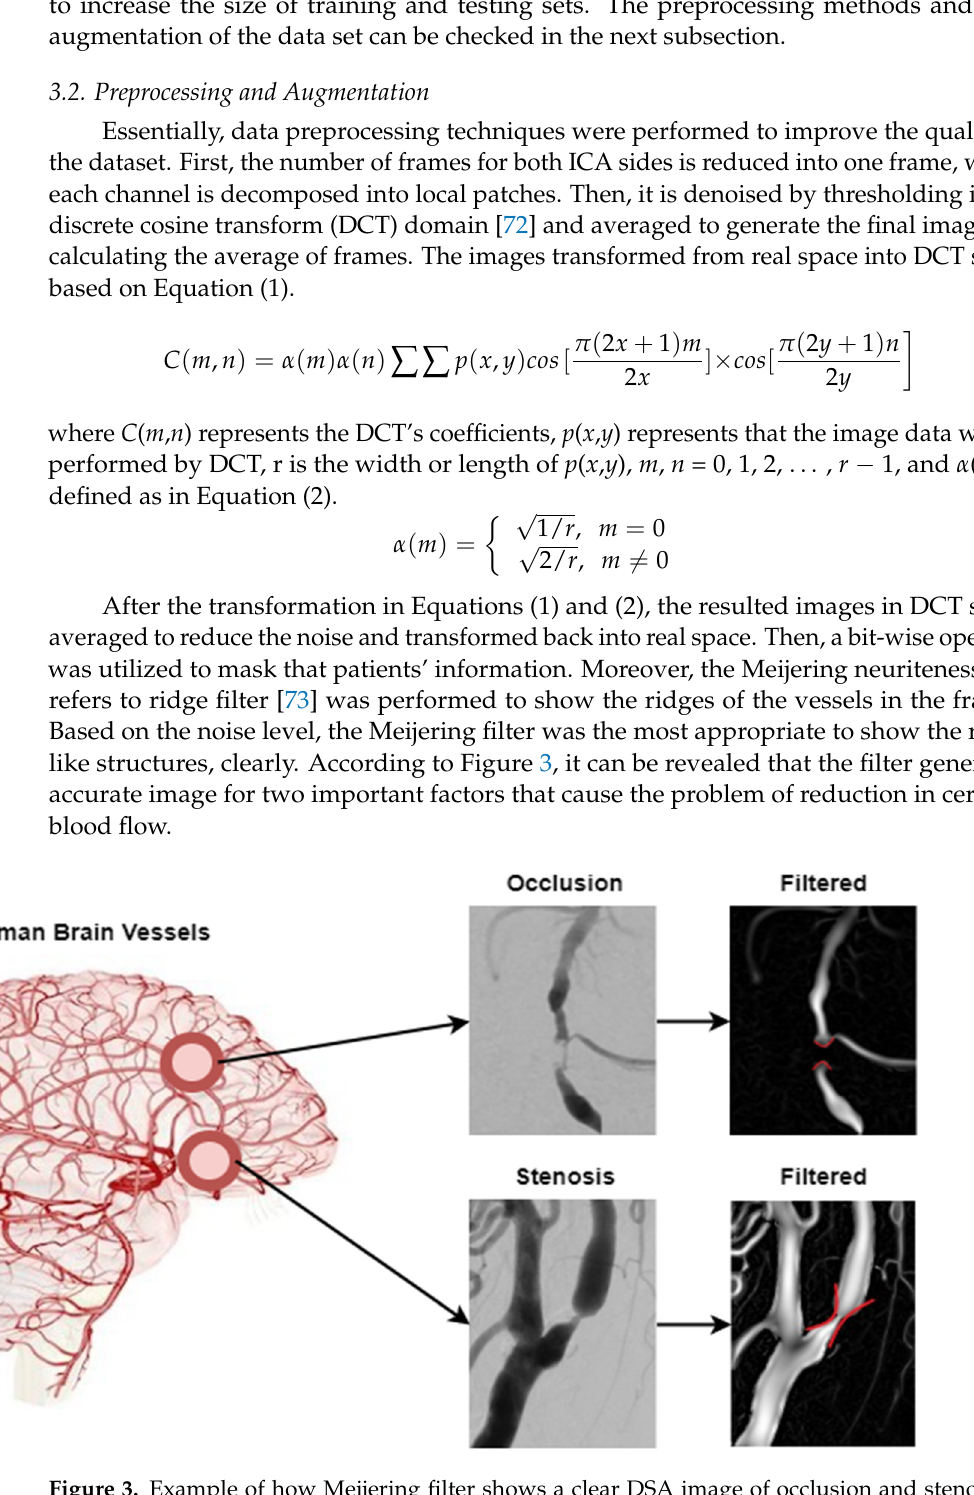
Figure 4. Sample of DSA scans after performing preprocessing. Data augmentation was performed to increase the amount of data [74], in which slightly modified copies of scans were added based on the existed scans. Four samples were obtained using rotation: width shifting, height shifting, and shearing methods, where the used filling mode is constant. Thus, added samples help reduce overfitting dur- ing the training process of the model. Finally, the samples of Alzheimer’s disease in- creased to 104 images, and the samples of normal controls increased to 108 images, where all images resized to 255 × 255 pixels and normalized by rescaling the pixels to a range between zero and one. 3.3. Proposed Framework CNN is a kind of feedforward artificial neural network that is popularly used for image recognition purposes. It can operate directly on raw input such as pixels, which effectively automates feature selection [75]. A general model of CNN consists of four com- ponents, namely, input layer, convolution layer, pooling layer, fully connected layer, and